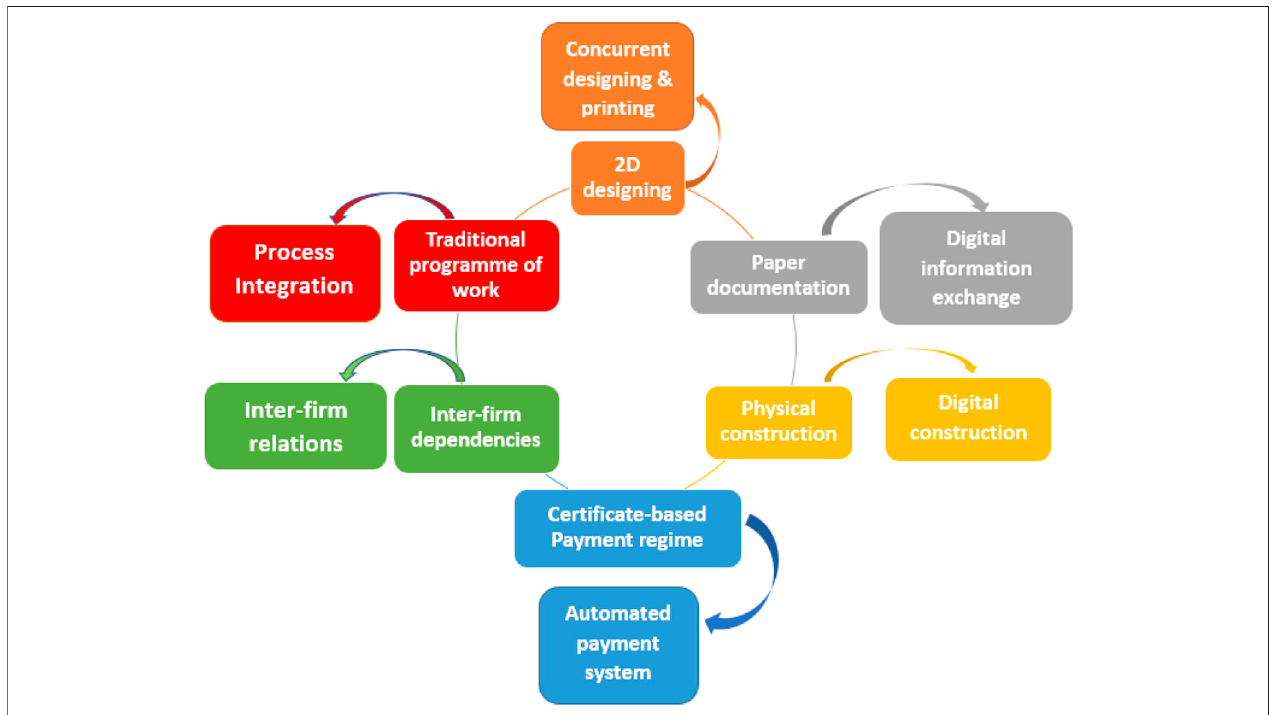
FIGURE 6 | Construction activity fi elds and their digital